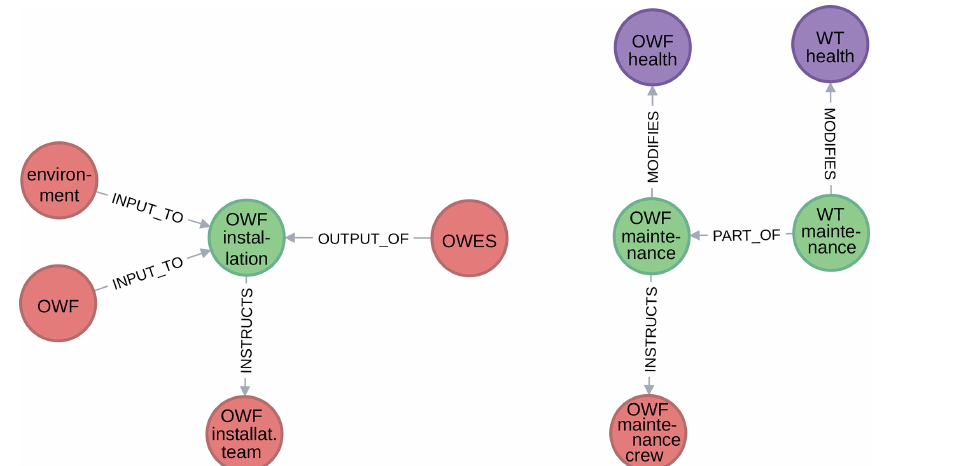
Figure 9. Excerpts from WESgraph of the subgraph defined by the INSTRUCTS relationship and its context.